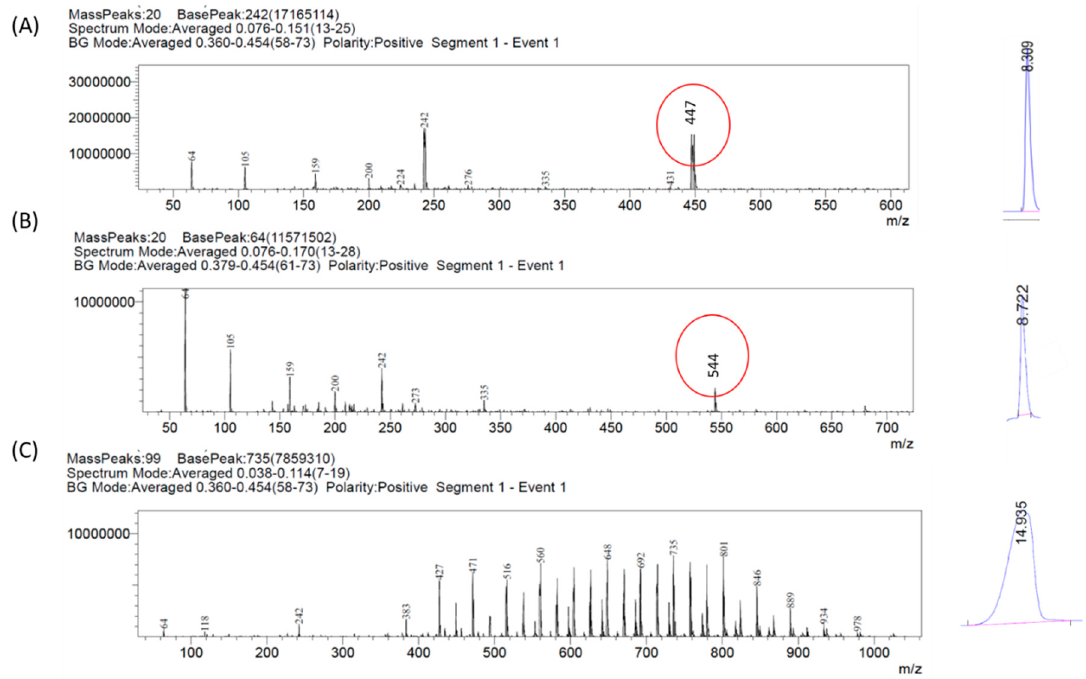
Figure 6. Confirmation of molecular weights of peak eluents using a mass spectrometer showing the presence of ( A ) gefitinib, ( B ) GSK461364A, and ( C ) polymer (PLGA-PEG).